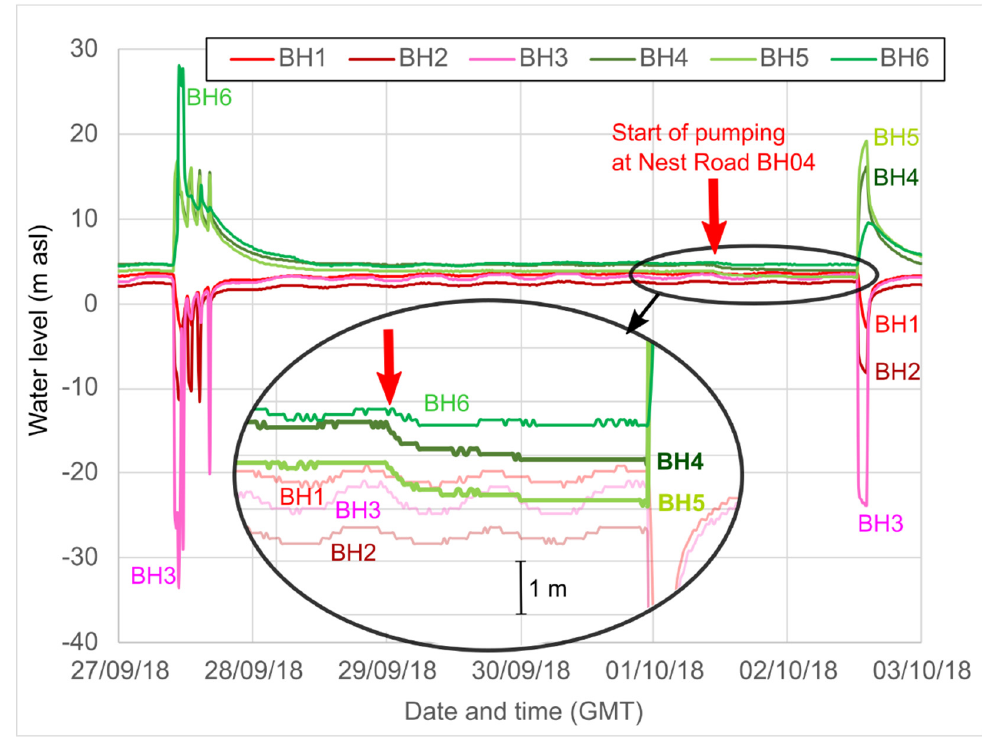
Figure 10. Water levels (m asl) logged by the building management system (BMS) at Abbotsford Road, October 2018. The elliptical inset shows an enlargement of the response to the start of the pumping test (shown by vertical red arrow) at Nest Road BH04 (c. 735 m away from the Abbotsford reinjection wells) with reinjection to BH02. Note also the large tidal fluctuations in Abbotsford BH1 to BH3.